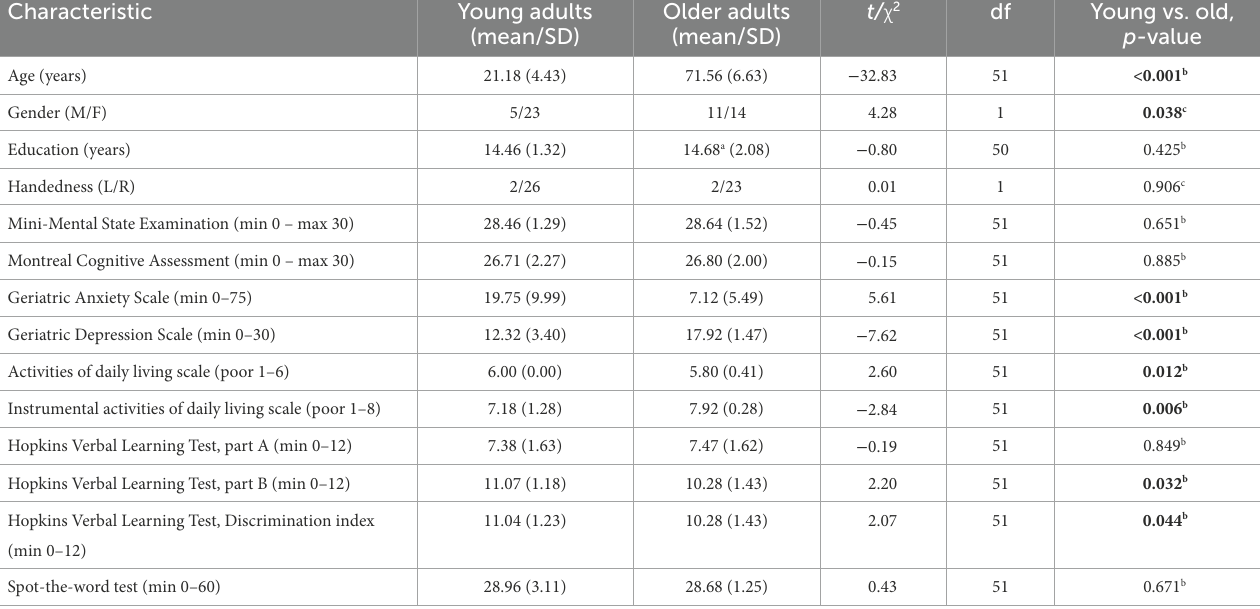
TABLE 1 Demographic data and results of the screening tests of the young and older adult participants.